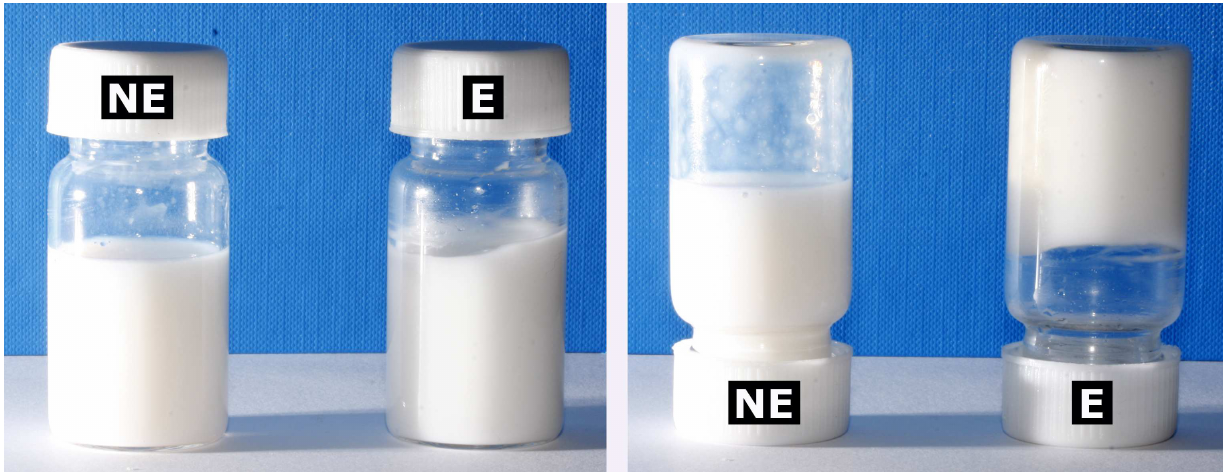
Figure 1. Visual appearance of a sucrose stearate-based macroemulsion (E) and a corresponding nanoemulsion (NE). Age of the presented formulations: 9